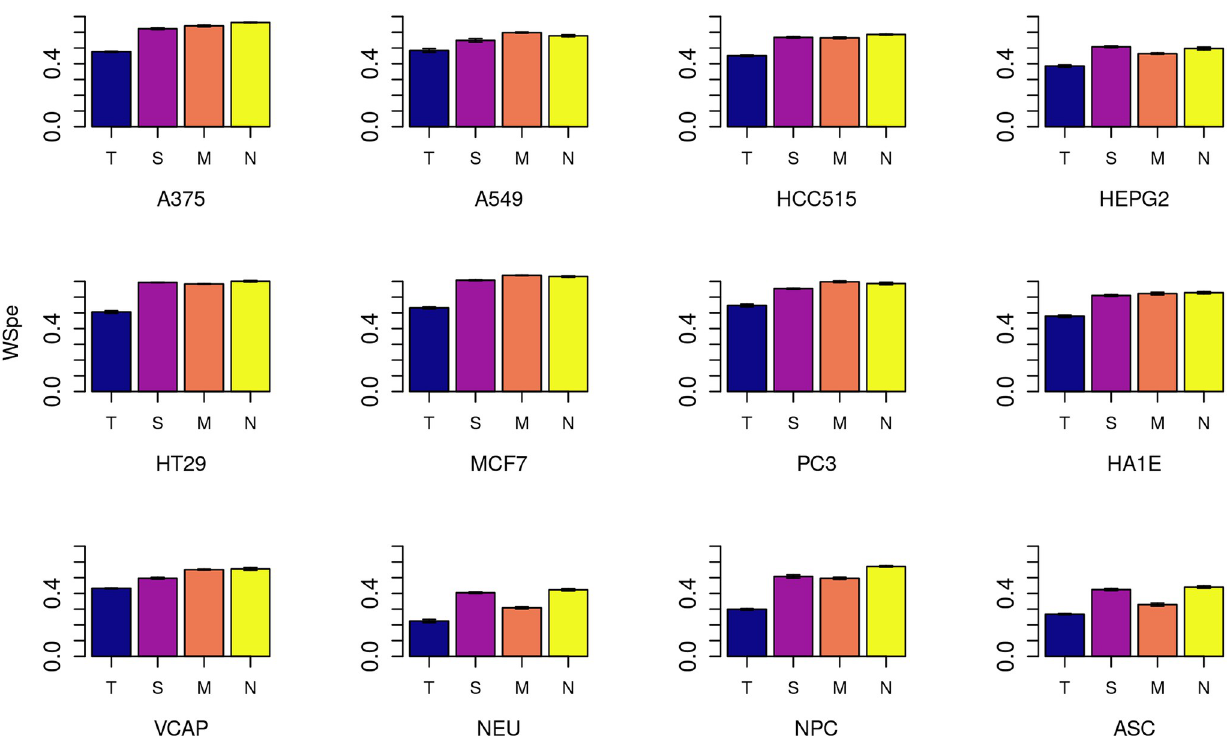
Fig 2. Negative connectivity results. Weighted Spearman rank correlation (WSpe) scores for negative connectivity across all genes and drugs, for each of the 12 cell lines in the complete data set. Methods are denoted by single-letter labels: T: Tissue-agnostic; S: SVD; M: Median of medians; N: Neighborhood collaborative